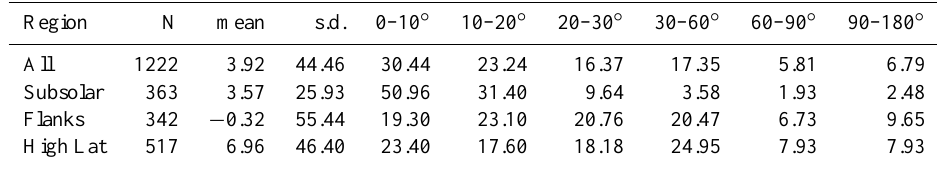
Table 5. Distribution of angular differences in the Northward IMF case (IMF clock angle between − 15 ◦ and 15 ◦ ). Format as in Table 3. Region N All